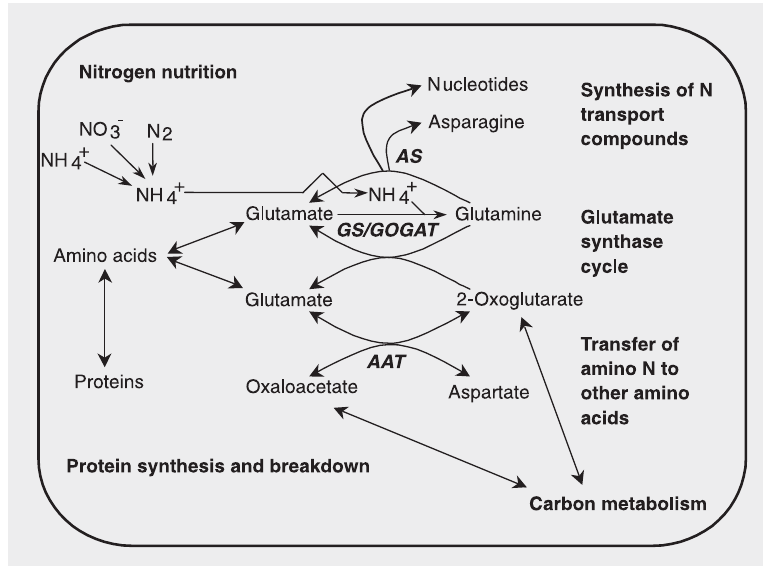
Figure 1. Enzyme reactions important in the assimilation of ammonia. GS = glutamine synthetase; GOGAT = glutamate synthase; AS = asparagine synthetase; AAT = aspartate